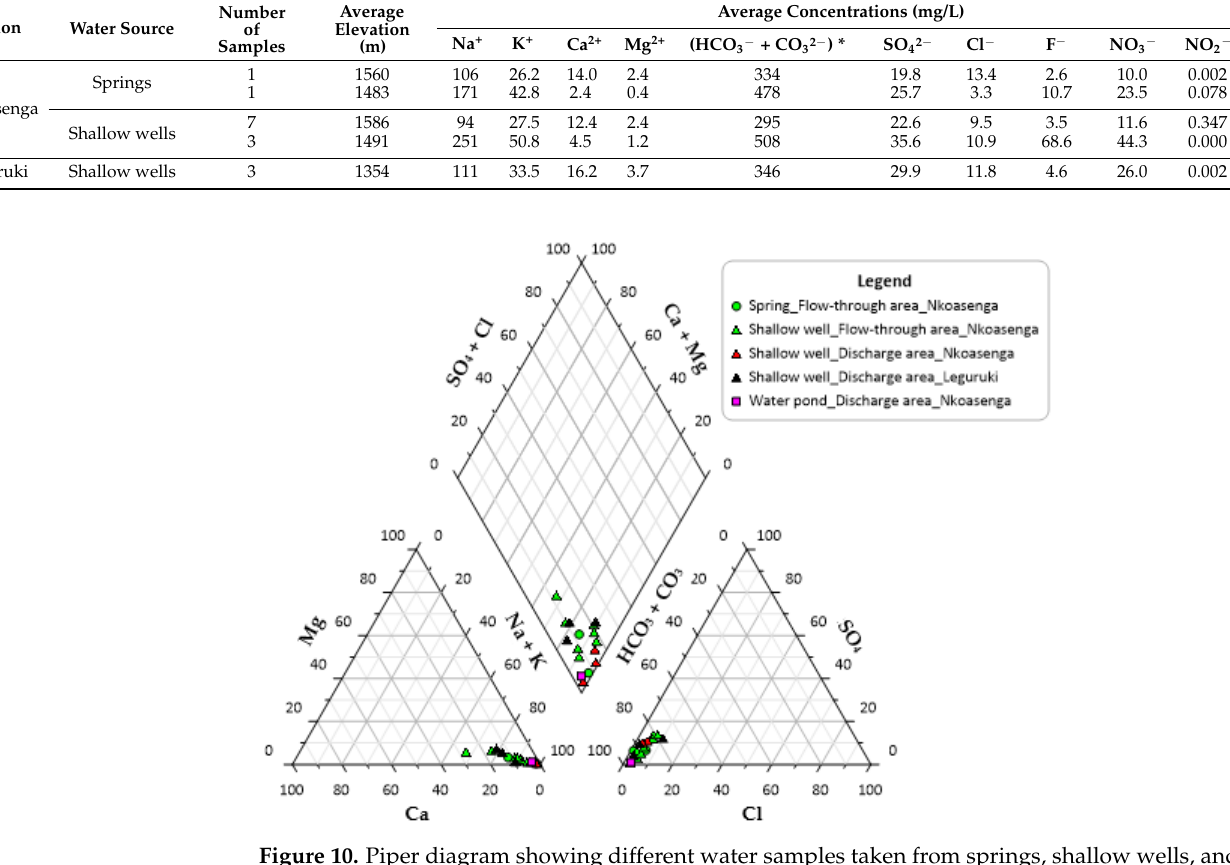
Figure 10. Piper diagram showing different water samples taken from springs, shallow wells,